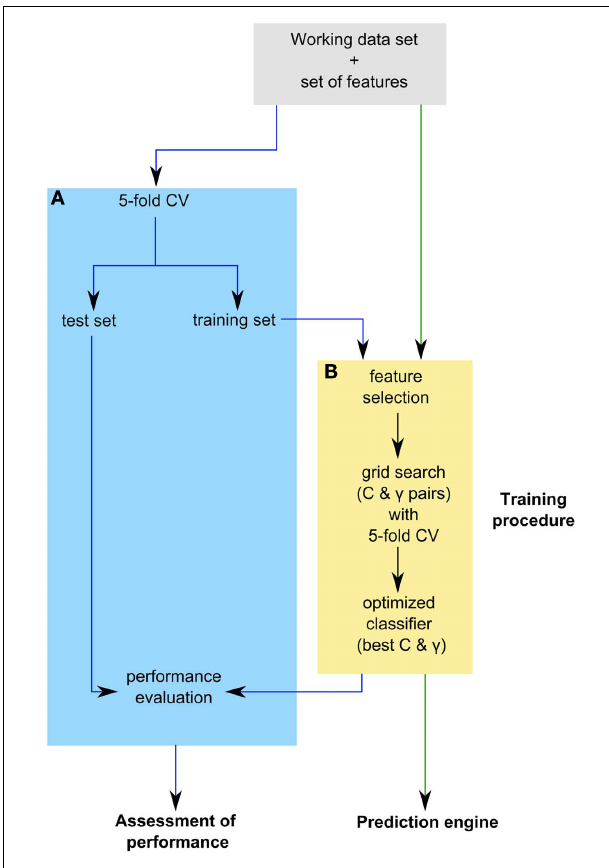
FIGURE 1 | Outline of prediction engine construction and evaluation. The prediction engine was constructed and its performance was evaluated in two independent runs on the entire working data set, as indicated by the green and blue arrows respectively. (A) Assessment of prediction engine performance through fivefold cross-validation (CV) loop. In each fold of CV an optimized classifier is built on the training set and its performance is assessed on the test set.The resulting performance measure distribution of the optimized classifiers was used to assess the performance of the prediction engine. (B) The training procedure used during prediction engine construction and evaluation.The training of a classifier involved feature selection and estimation of the best Cost (C) and gamma ( γ ) parameters using a grid search with fivefold CV loop.The best performing parameter pair was then used to train an optimized classifier.